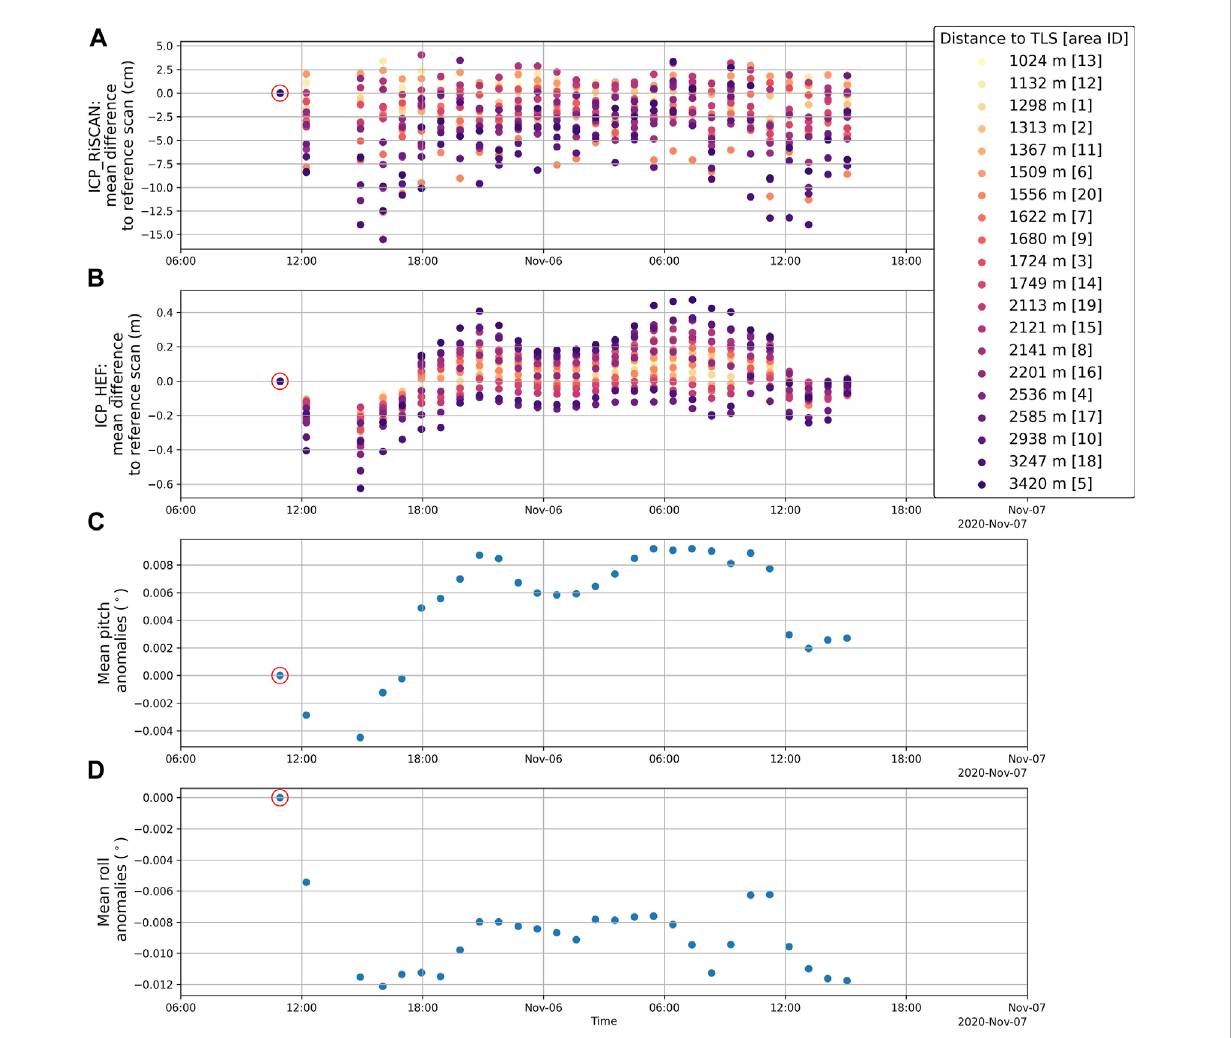
FIGURE 2 Mean difference of 20 selected areas relative to the reference scan of 5 November 10:55 (red encircled) with (A) ICP RiSCAN (in cm) and (B) ICP HEF (in m). Mean (C) pitch and (D) roll as measured by the internal inclination sensors. The legends in (A) and (B) correspond to the areas in Figure 1C , sorted to the distance from IHE. Please note the different orders of magnitude of the different registration methods in (A) and (B)